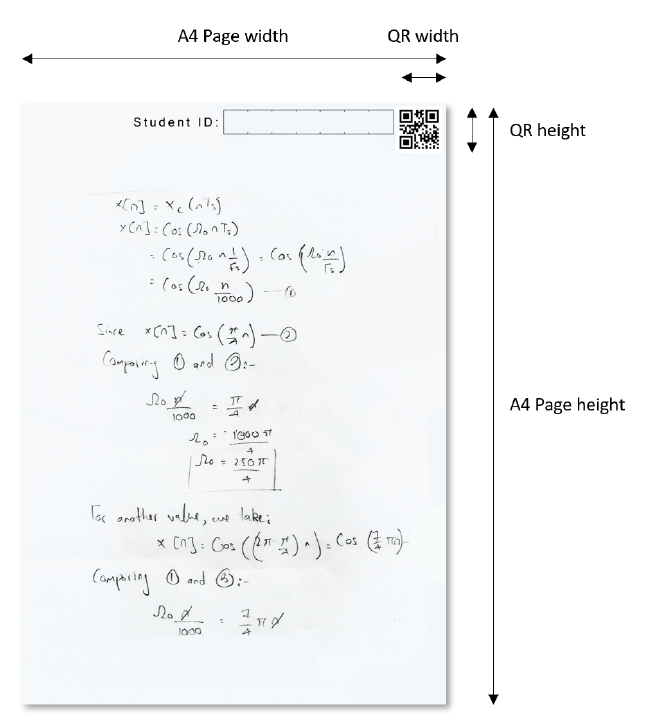
Figure 10. Simple crop